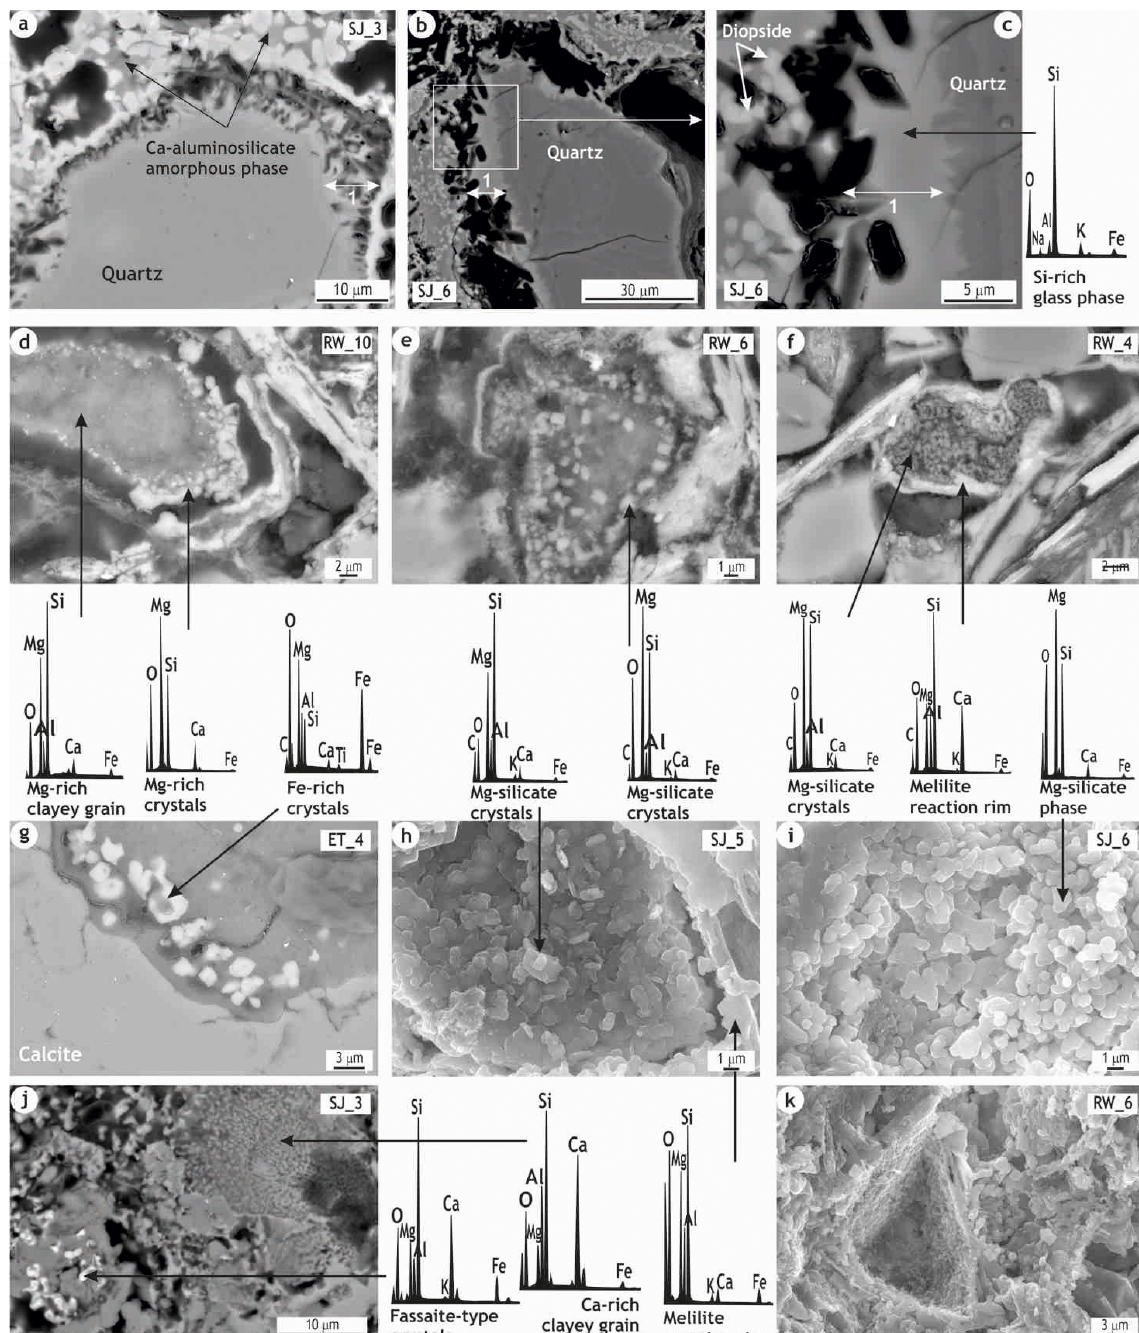
Figure 4. HRSEM BSE/SE images and associated EDS spectra of specific features observed in the ceramic bodies. (a) Pores within the silicate amorphous phase produced by quartz boundary transformation (1), next to the Ca-aluminosilicate phase where diopside crystals nucleated; (b, c) detail of the pores and quartz edge; these pores have the same shape as the pyroxene-type crystals they may once have hosted – note the large polygonal pores maybe due to the dissolution of the silicate phase (1) by Ca-rich solutions once the bricks were laid, as suggested; (d) early melilite rim and ring of Mg-rich crystals at the Mg clayey grain boundary; (e) differential nucleation of the Mg-silicate mineral phases; (f) heavily reacted Mg clayey grain, which was totally transformed into Mg-silicate crystals, and a well-developed melilite reaction rim; (g) Fe-rich crystals probably corresponding to an intermediate member of the forsterite–fayalite solid solution; (h, i) SE images of the Mg-silicate phases, with plate shapes evolving to rounded morphologies with the increase in temperature; (j) partially decomposed Ca-rich clayey particle and development of fassaite-type pyroxenes; (k) rhombohedral shape void formed due to the total consumption of a pristine carbonate